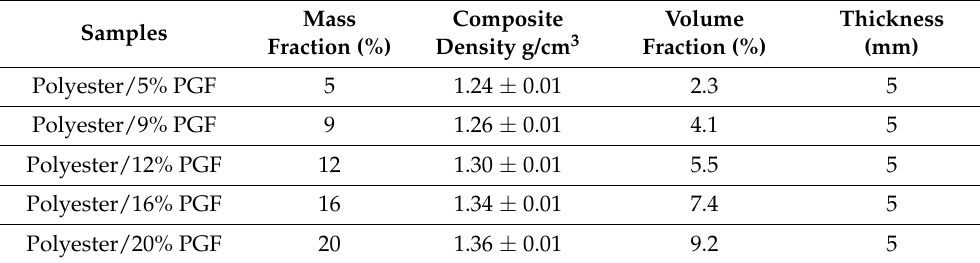
Table 3. Characteristics of developed composite